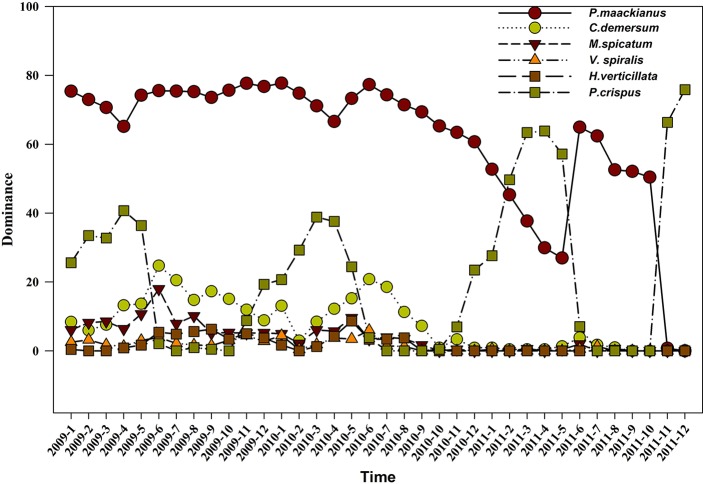
The species dominance of the submerged plants in 2009, 2010, and 2011.